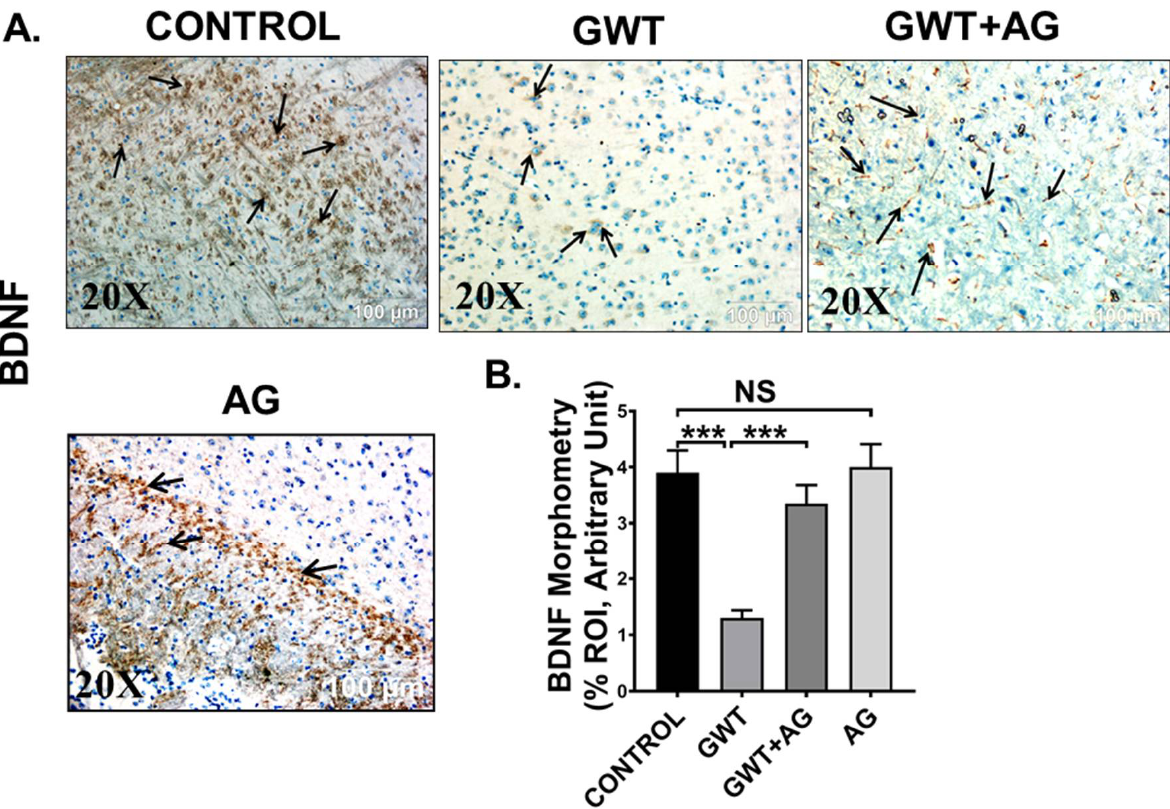
Figure 9. AG restores BDNF expression crucial for neurogenesis. Representative immunohistochemistry images of ( A ) BDNF immunoreactivity in the brain sections (the frontal cortex is focused) of CONTROL, GWT, GWT+AG, and AG mice groups. Images were captured in 20 × magnification and immunoreactivity was indicated by black arrows. ( B ) Morphometric analysis (calculated as %ROI) of (BDNF immunoreactivity. Y -axis represents % positive immunoreactive area (% ROI) ( n = 3; mean value taken from three separate microscopic fields) (*** p < 0.001, NS: non-significant). Data were represented as mean ± SEM and statistical significance was tested using unpaired t-test between the groups (* p < 0.05, ** p < 0.01, *** p < 0.001), followed by Bonferroni Dunn Post hoc corrections.